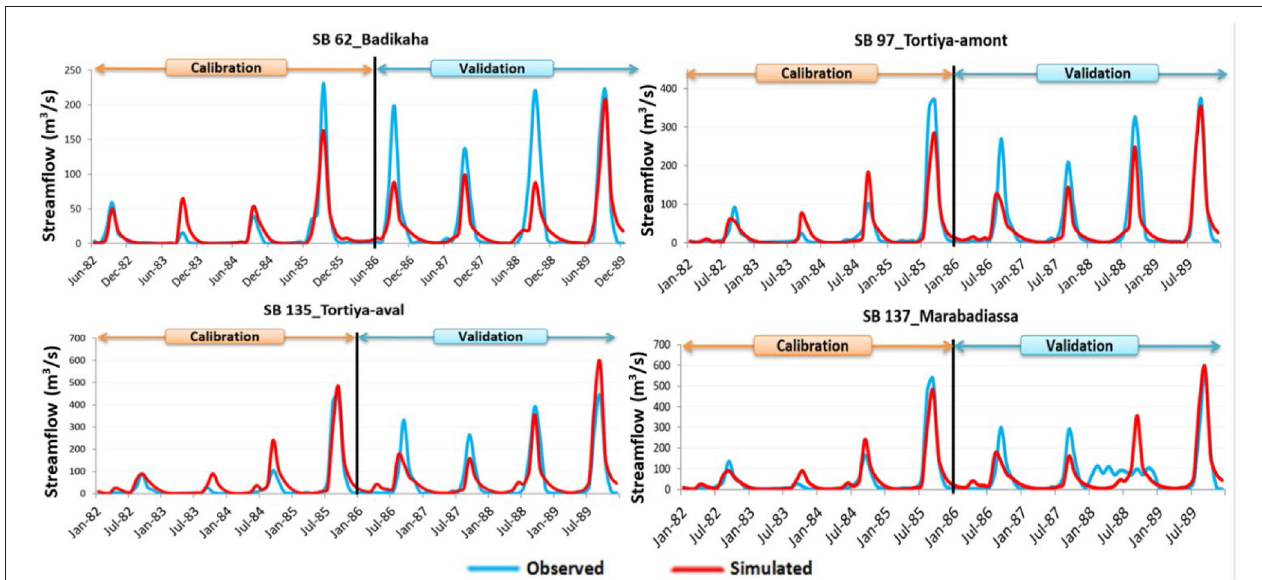
FIGURE 4 | Calibration and validation of the WBW SWAT model in SB 62 (Badikaha station), SB 97 (Tortiya-amont station), SB 135 (Tortiya-aval station), and SB 137 (Marabadiassa station).